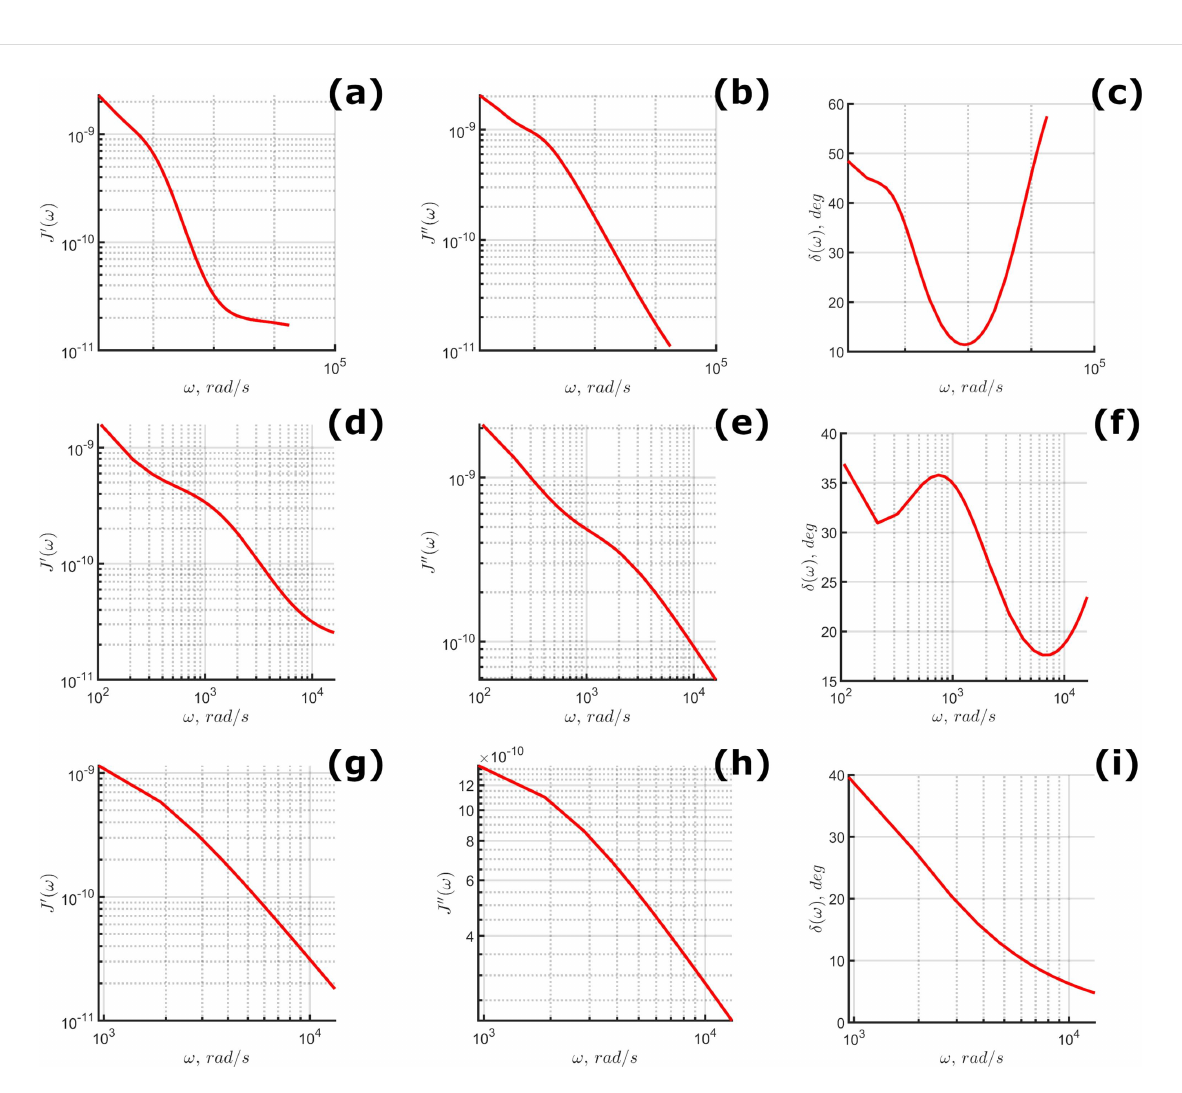
Figure 7: Predicted harmonic quantities for 10 nm/s (top row), 100 nm/s (middle row), and 1000 nm/s (bottom row) approach velocity. (a, d, g) Calcu- lated storage compliance; (b, e, h) calculated loss compliance; (c, f, i) calculated loss